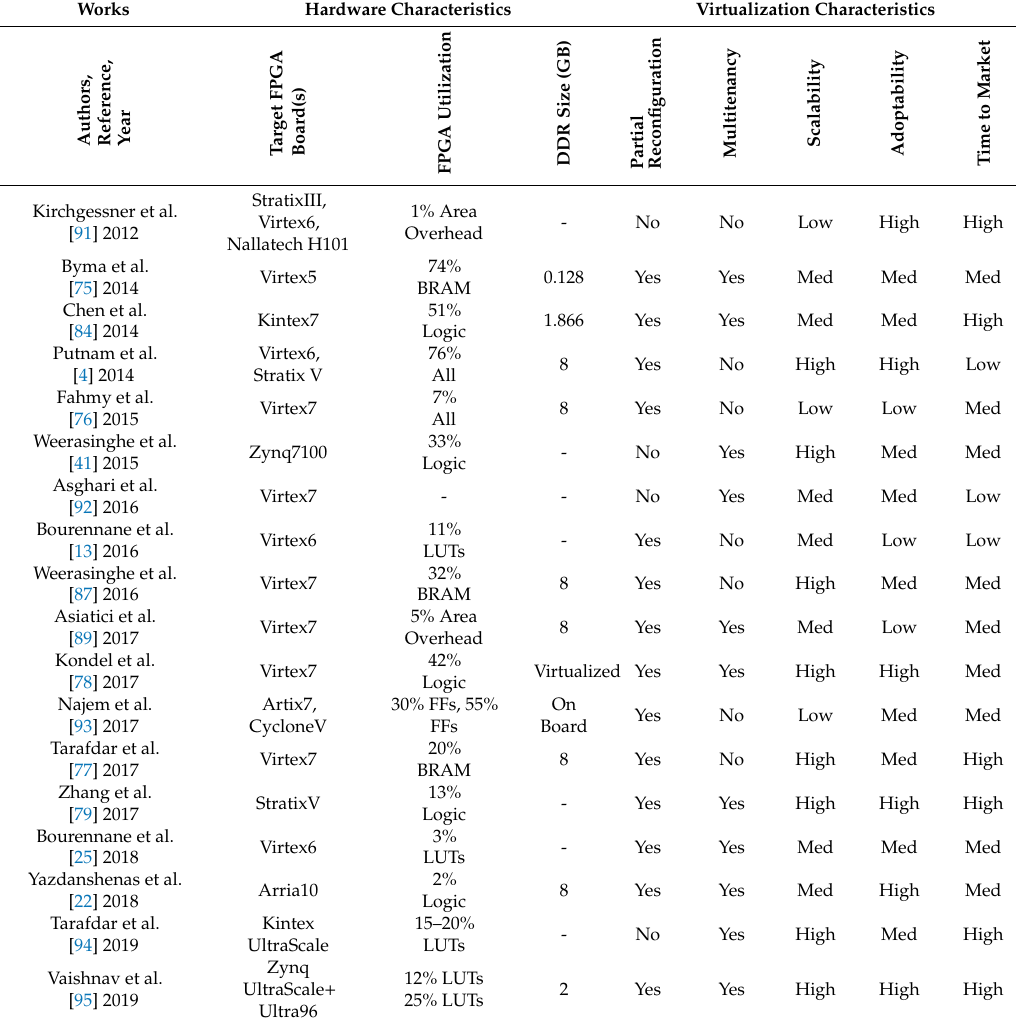
Table 5. Research Highlights of the